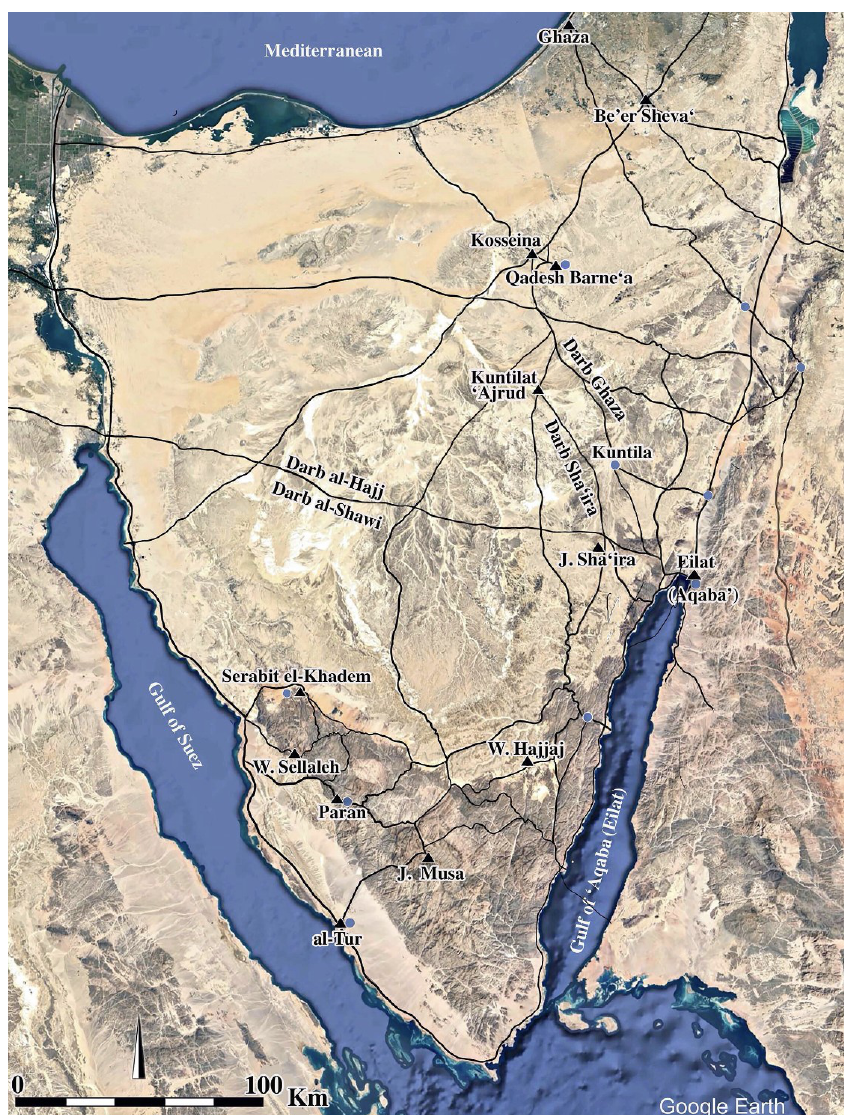
Figure 11 Map of the Negev and Sinai, showing the sites mentioned in the text and the main ancient roads.